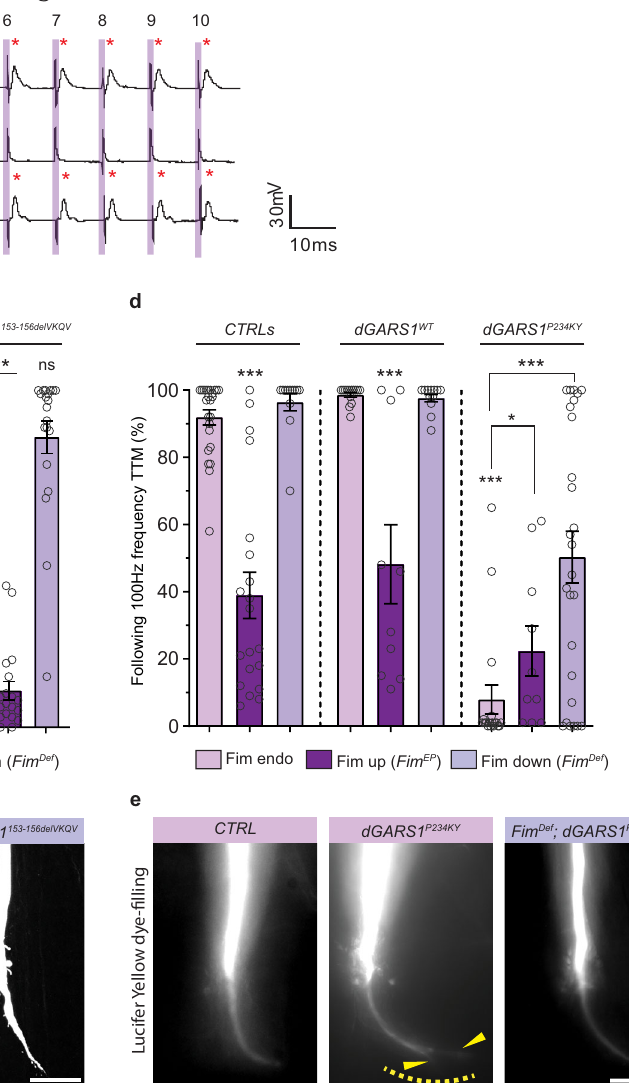
( Fim Def ; YARS1 153-156delVKQV ). Yellow dashed line depicts constrictions at the axonal terminal in the mutant. Scale bar – 20 µ m. d The same electrophysiological para- digm wasused to evaluate the ability of the GF/TTMn synapse to follow repetitive stimuli in control, GARS WT and GARS CMT – expressing animals, by changing the expression levelsof Fim; n =24, 20, 12, 14, 10, 12, 18, 10, and 26 (from left to right) giant fi berrecordingsfrom8-day-oldfemale fl ies;* p =0.0159and*** p <0.001,bya two-sided Mann-Whitney test. Controlsare reused in graph b and d . Data in b and d presented as mean values±SEM. e GF terminal morphology visualized with lucifer yellow GF dye- fi ling in CTRL , GARS1 CMT , and fl ies with improved GF/TTMn responses ( Fim Def ; GARS1 CMT ). Yellow dashed line depicts the thin, irregular axonal terminal that splits in two (yellow arrowheads) in the mutant. Scale bar – 50 µ m. Source data are provided as a Source data fi